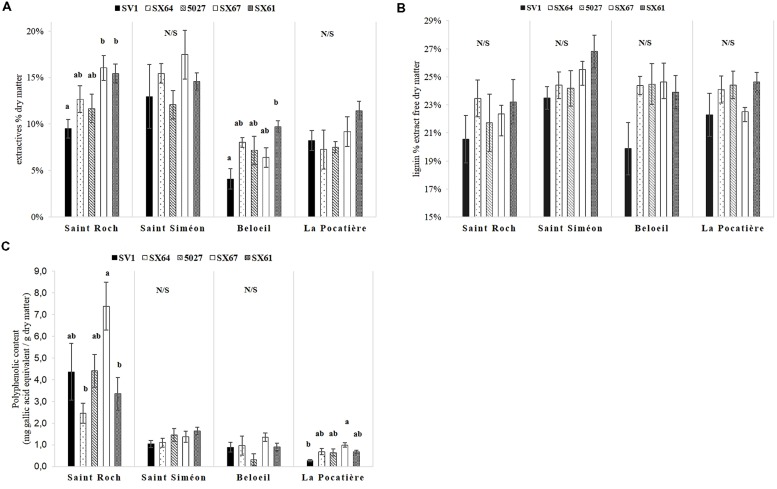
Five willow cultivars in their second year of a harvest cycle (Salix viminalis 5027, S. dasyclados SV1, S. miyabeana SX61, S. miyabeana SX64, S. miyabeana SX67) sampled at four field trials in Québec: Saint-Roch-de-l′Achigan, Beloeil, S-S and LP.
(A) Variation in extractives (toluene-ethanol/water extraction); (B) lignin content expressed as a percentage of dry matter and (C) total polyphenolics content (methanol-extractable). Error bars represent standard error, n = 4 blocks (four trees per block). Tukey’s HSD pairwise post hoc test (α = 0.05) are represented by letters a–b.